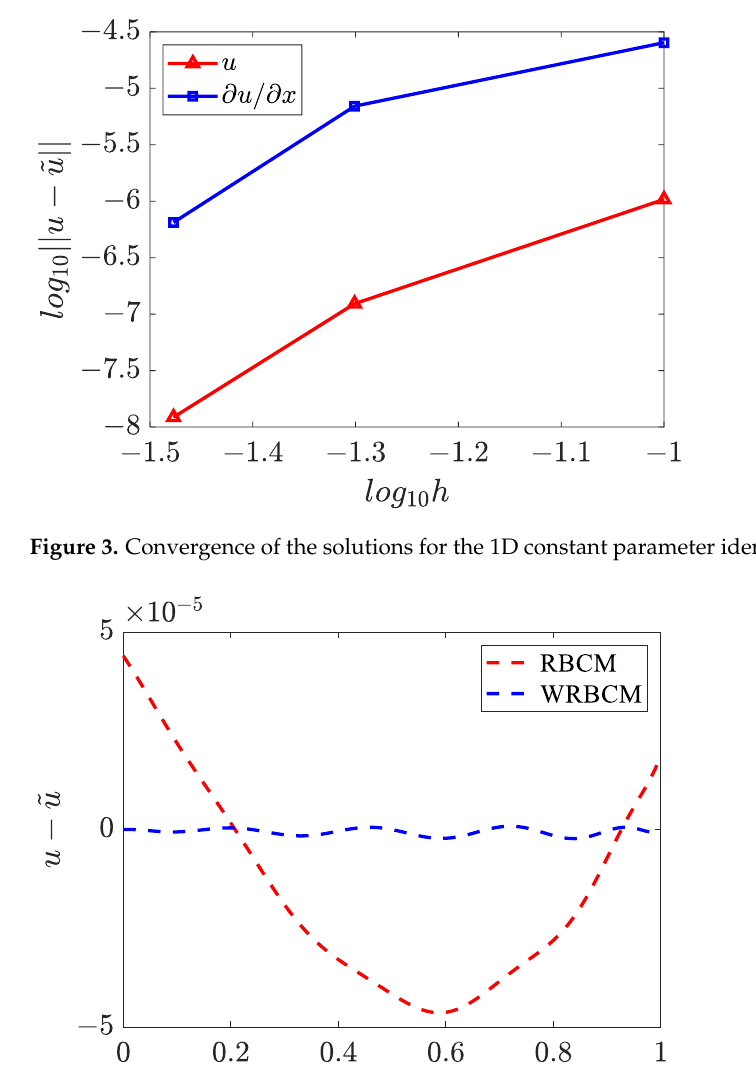
Figure 2. Solution and corresponding error for the 1D constant parameter identification problem: ( a ) solution; ( b ) corresponding error.